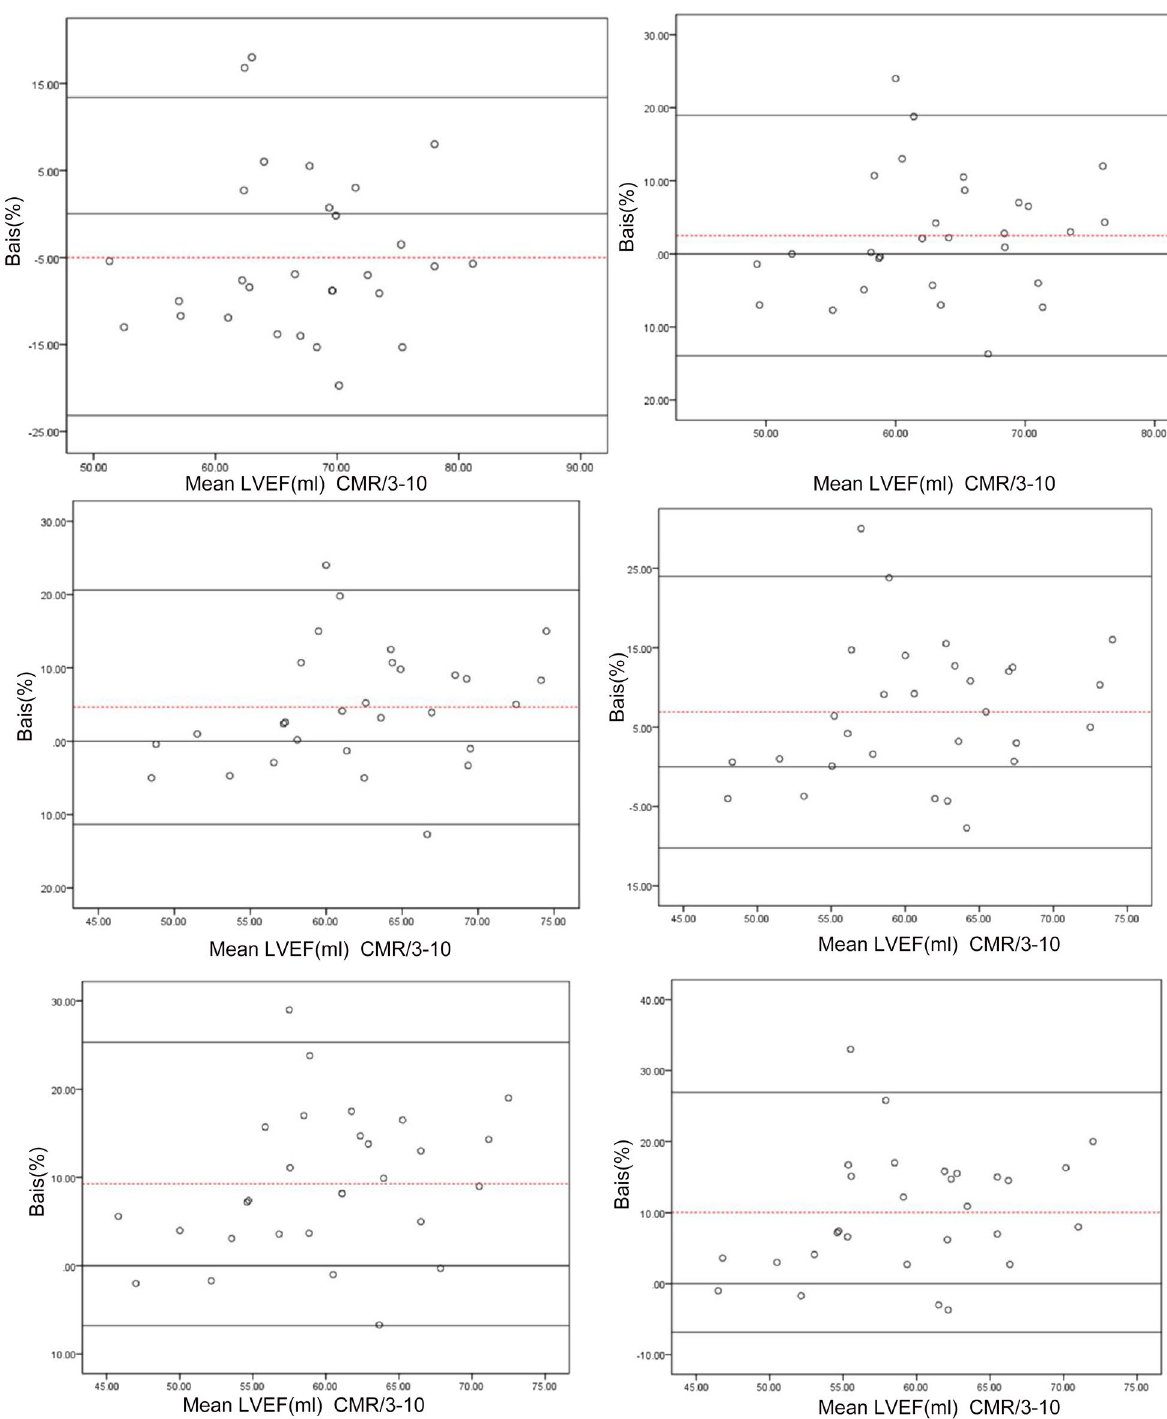
Fig. 5 Bland ‒ Altman test for consistency of the left ventricular ejection fraction measured by SPECT with different reconstruction parameters and by cardiovascular magnetic resonance (CMR) in the small-heart group. The dashed line represents the mean of the difference (Xd), and the three solid lines are the upper limit of agreement (LOA) of the difference (Xd to bottom, respectively. Xd mean of the difference; SD standard deviation of the